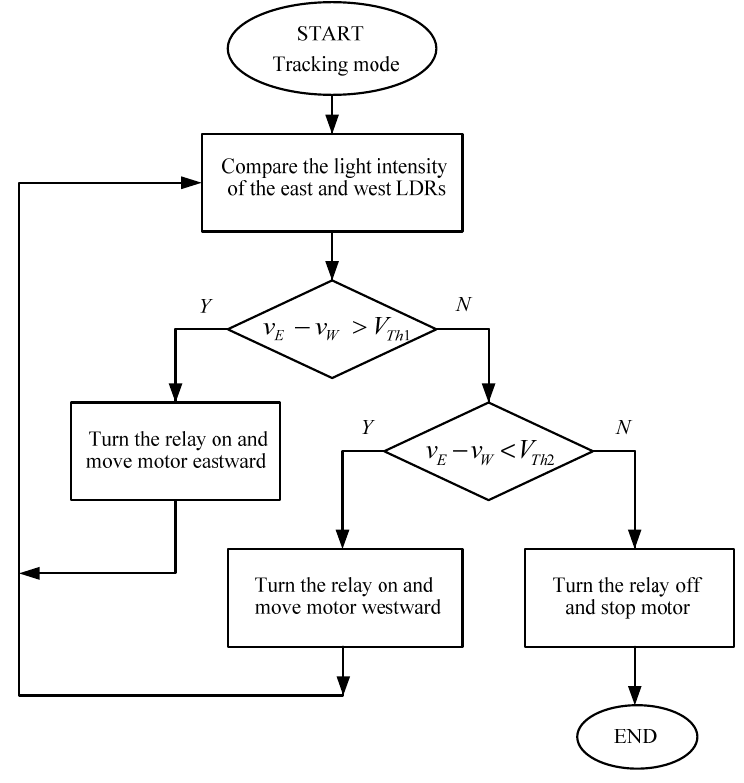
Figure 2. Flowchart of tracking algorithm for azimuth control.